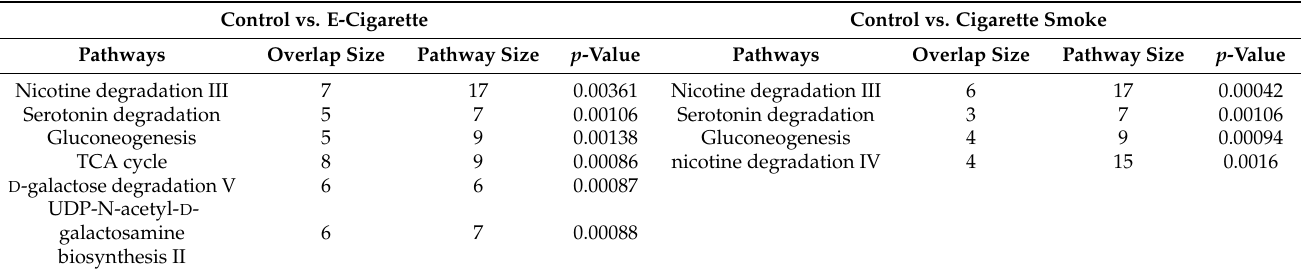
Table 1. Metabolic pathway dysregulation among non-smokers, e-cig users, and cigarette smokers. Control vs. E-Cigarette